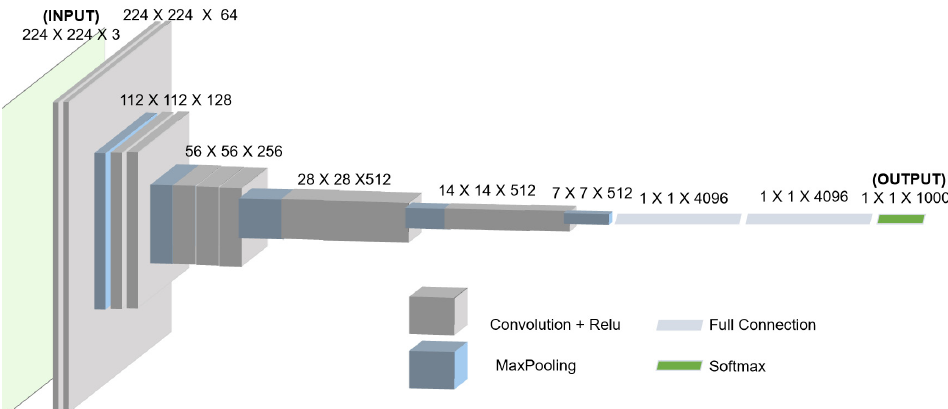
Figure 4. Architecture of VGG16. Each convolutional kernel size is 3 × 3, and the stride is 1. There are five maximum pooling layers over a 2 × 2 pixel window with a stride of 2. There are three FC layers following a Scheme 4096 channels, and the third one performs 1000-way ILSVRC classification. Soft-max layer is the last layer. The hidden layers are equipped with rectified linear unit (ReLU) nonlinearity.